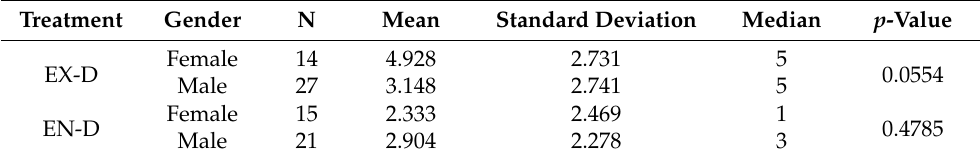
Table 5. Gender differences in dictator